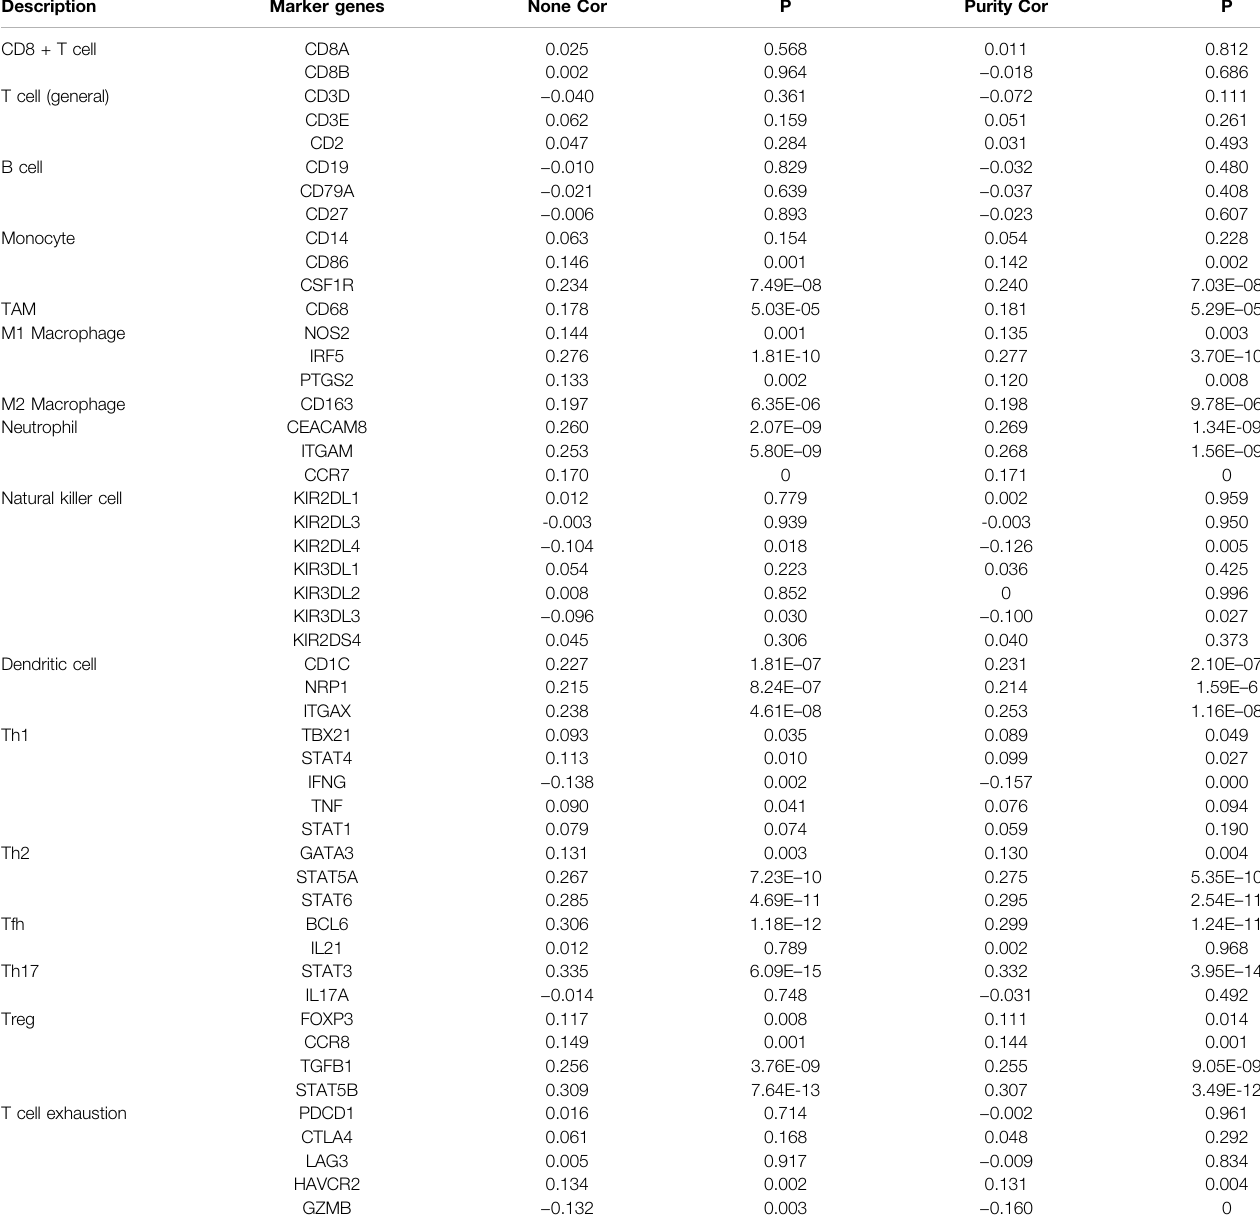
TABLE 3 | Correlation analysis between RAB11FIP1 and marker genes of immune cells in TIMER. Description Marker